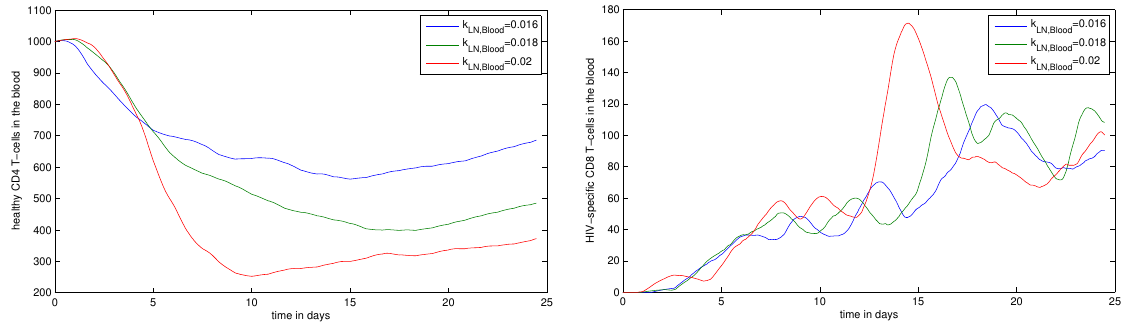
Figure 15. Sensitivity analysis for blood. The effect of the variation of the rate of CD8+ T cell migration from lymph node to blood ( k LN , Blood ) by ± 11%. ( left ) Uninfected CD4 + T cells (cell/ µ L); ( right ) HIV-specific CD8 + T cells (cell/ µ L).